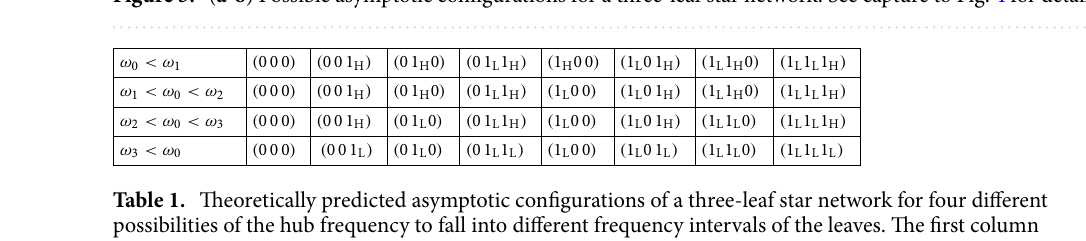
solutions were observed. For given parameter values, configuration ( 1 L 1 L 1 H ) with all synchronized oscillators (Fig. 5e) is most likely, and configuration ( 000 ) with all unsynchronized oscillators (Fig. 5o) is the least likely. N -leaf star network. The results obtained for two- and three-leaf star networks can be generalized for a star network with an arbitrary number of leaves. Assuming that each leaf in a N -leaf star network can be either synchronized or unsynchronized with the hub, we can construct 2 N different asymptotic configurations for any given hub frequency. Let us denote the code of the n th asymptotic configuration of an N -leaf star network ( k ) N 1 , and the superscript ( k ) identifies a specific as C n , where n is a natural number that varies from 0 to 2 − 1 when the hub frequency is less than the lowest frequency of the frequency range of the hub. We assign k = 2, . . . , N correspond to the inequalities ω k leaves ω 0 < ω 1 . The values k 1 < ω 0 < ω k . Finally, we assign = −